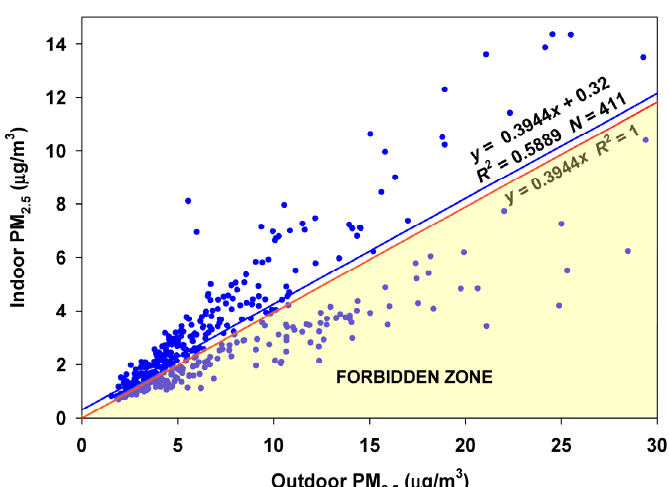
Figure 7. Random Component Superposition (RCS) regression for the Redwood City site. The slope ( F inf ) of 0.3944 results in many datapoints falling into the Forbidden Zone (below the estimated outdoor-penetrated particles given by the red line).